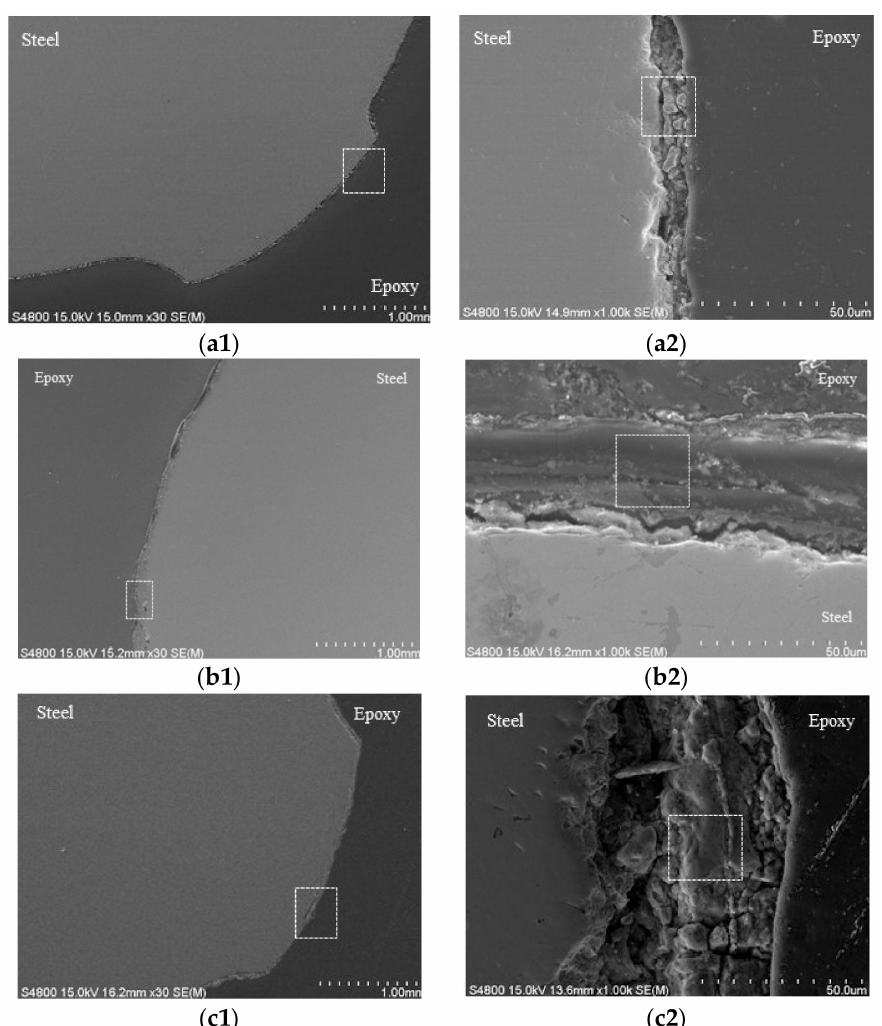
Figure 6. SEM image of steel rebar section: ( a1 ) Group A ( × 30), ( b1 ) Group B ( × 30), and ( c1 ) Group C ( × 30), ( a2 ) Group A ( × 1000), ( b2 ) Group B ( × 1000), and ( c2 ) Group C ( × 1000); -2 image shows the boxed